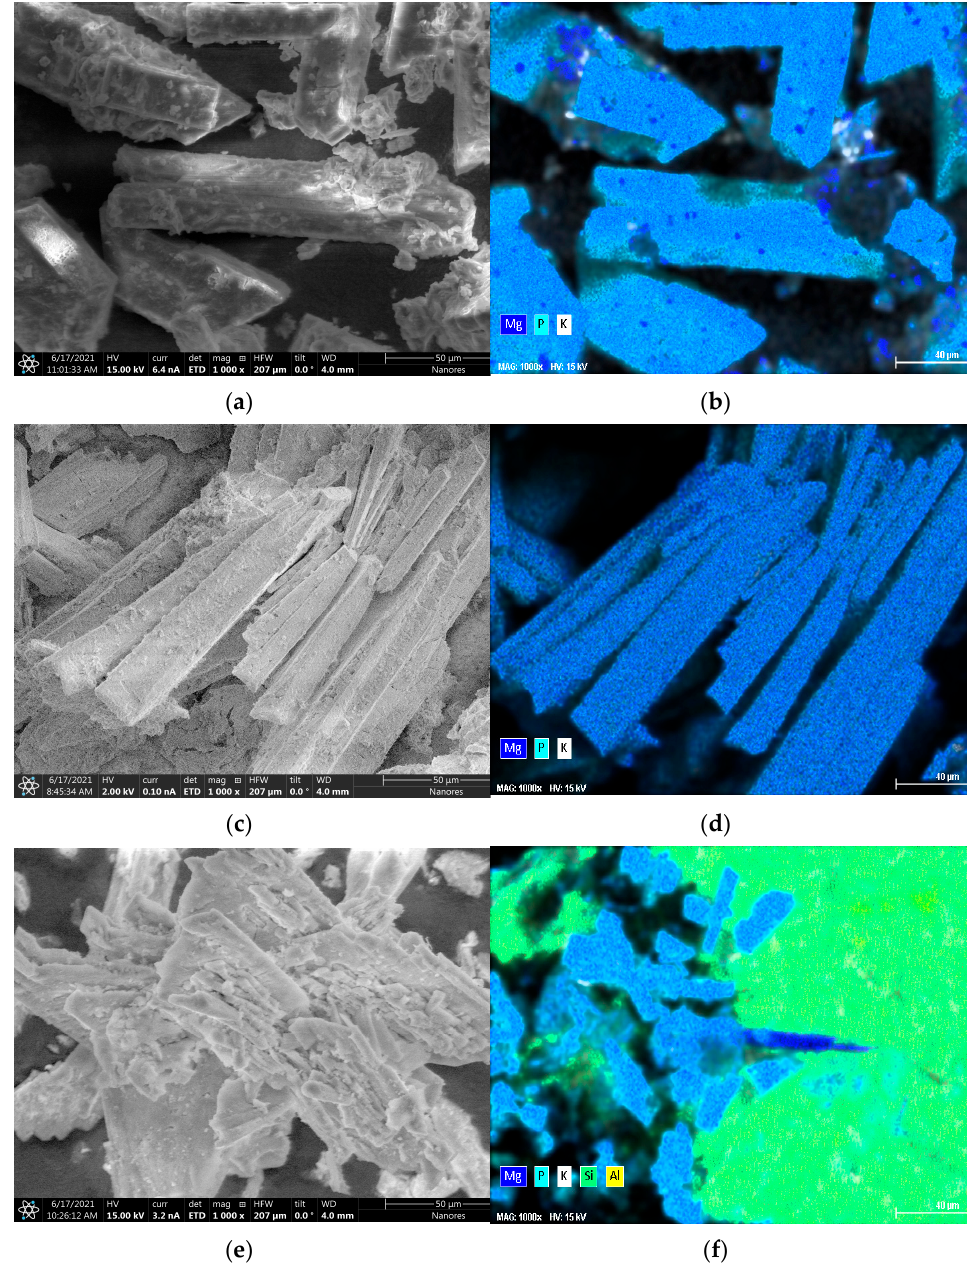
Figure 4. SEM-EDS images for DA ( a ) and its elemental mapping ( b ); for GA ( c ) and its elemental mapping ( d ); for GAZ ( e ) and its elemental mapping ( f ).